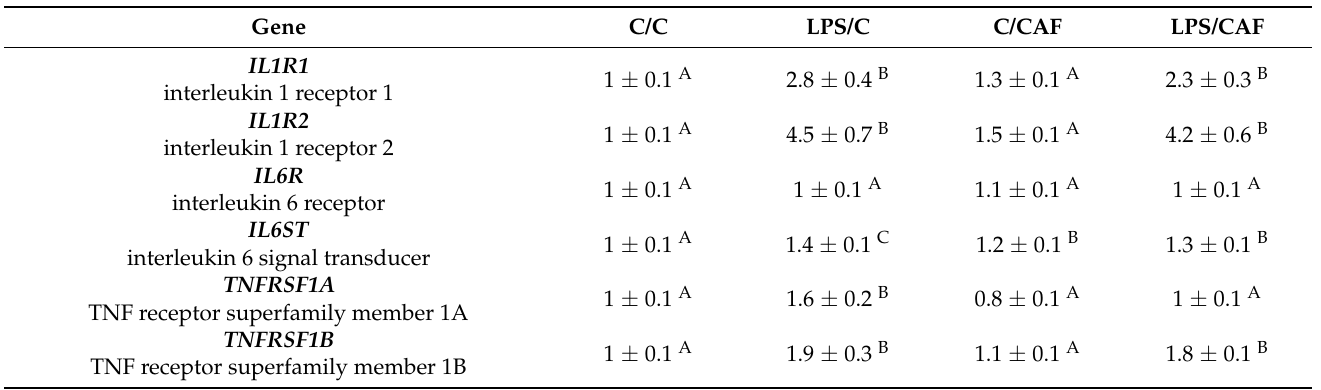
Table 1. The effect of caffeine on the relative gene expression (mean ± SEM; n = 6) of pro-inflammatory cytokines receptors in the ovine hypothalamus in basal and lipopolysaccharide-challenge conditions.